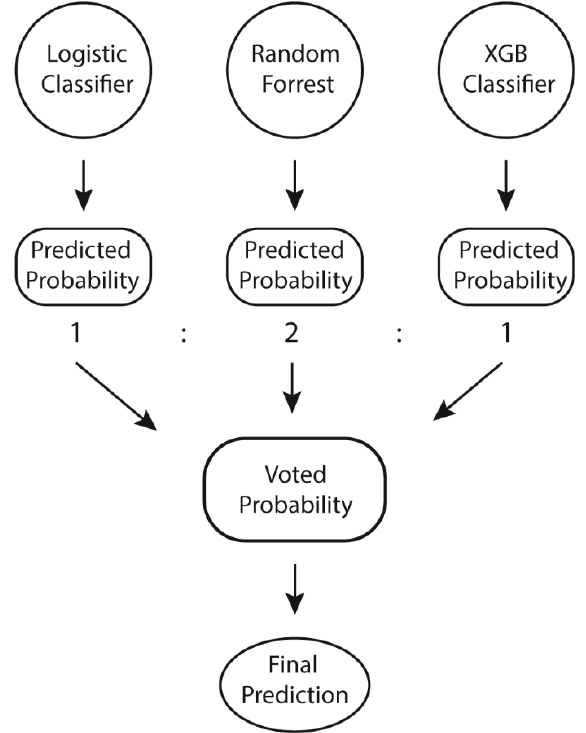
Figure 2. Voting classifier structure and weight of each model.